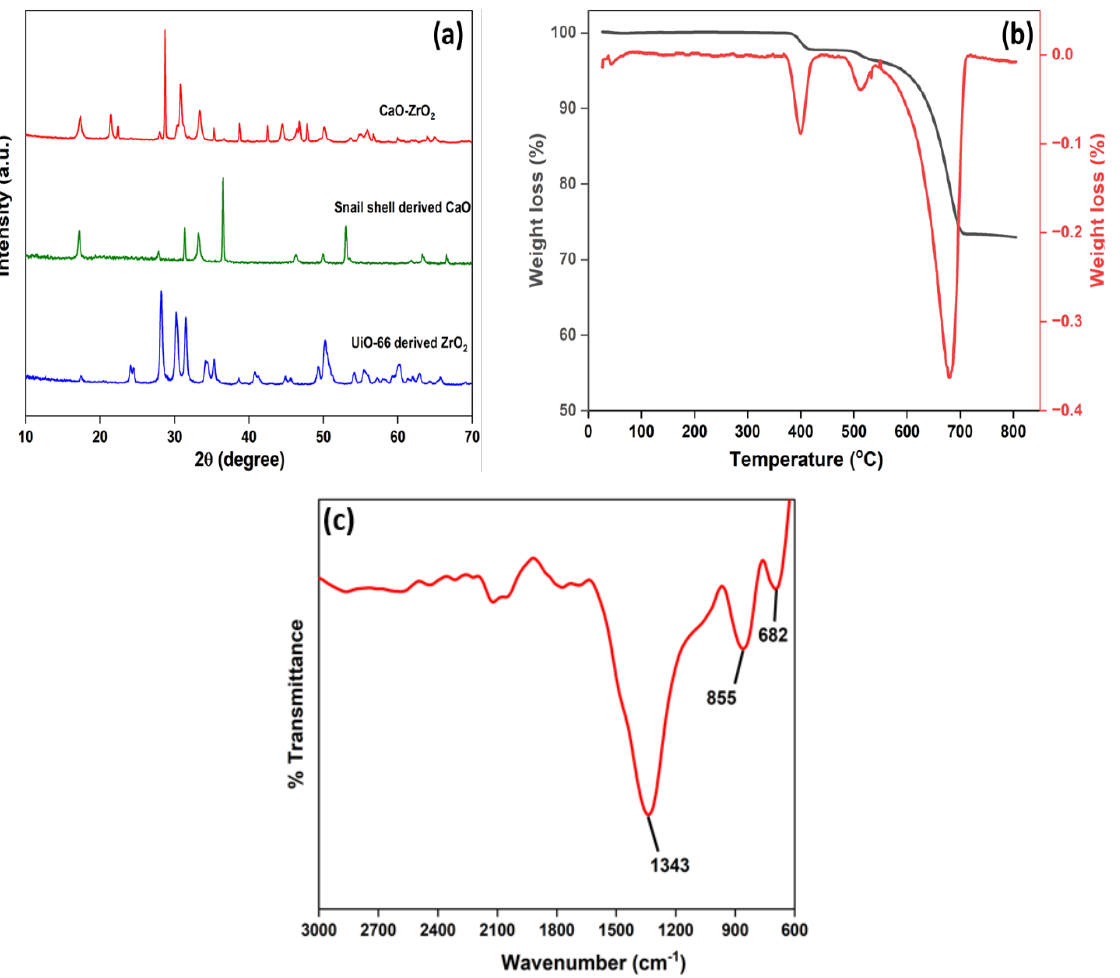
Figure 2. ( a ) XRD of the catalyst CaO − ZrO 2, ( b ) TGA of the catalyst precursor, and ( c ) FT − IR of the catalyst.